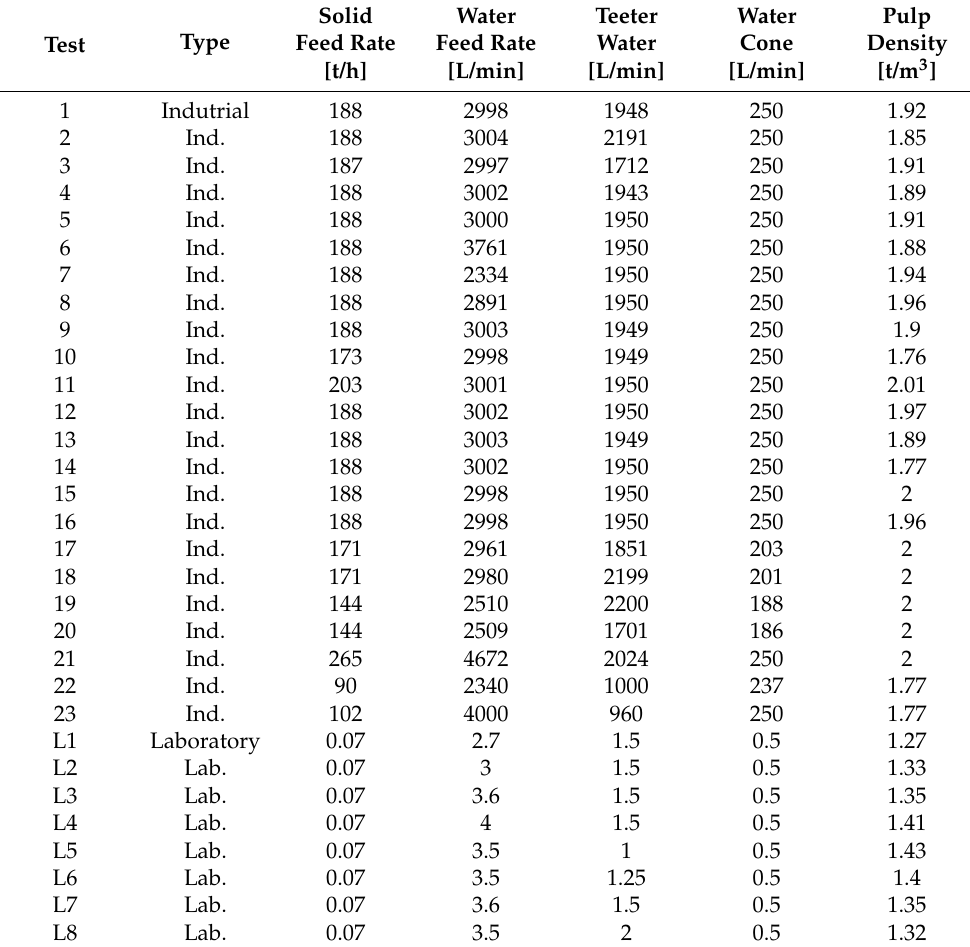
Table 2. Operating conditions of experiments on industrial, and laboratory